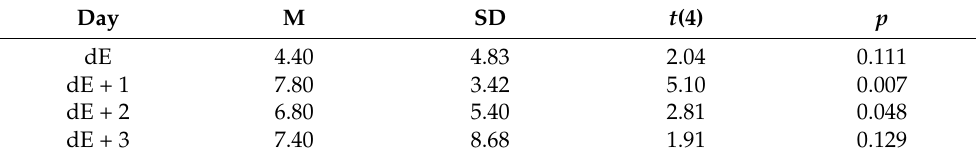
Table 6. Means and standard deviations of behavioral reactions to corn of Group 2 ( n = 5).